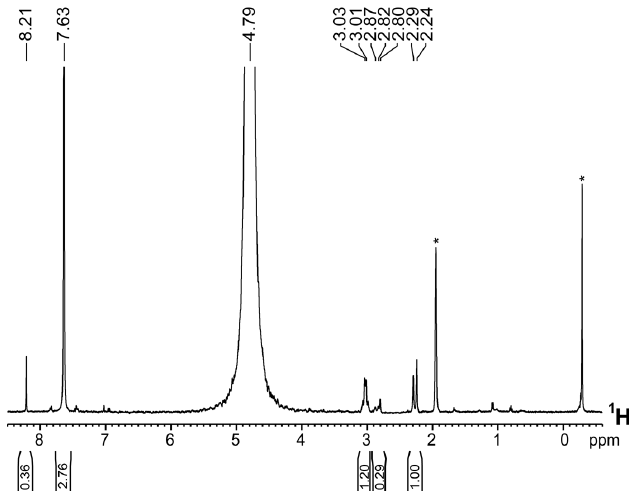
Figure 5. 1 H-NMR spectrum of hydrolyzed Ir@UiO-66(1) sample [NaOD/D 2 O, 298 K; * denote